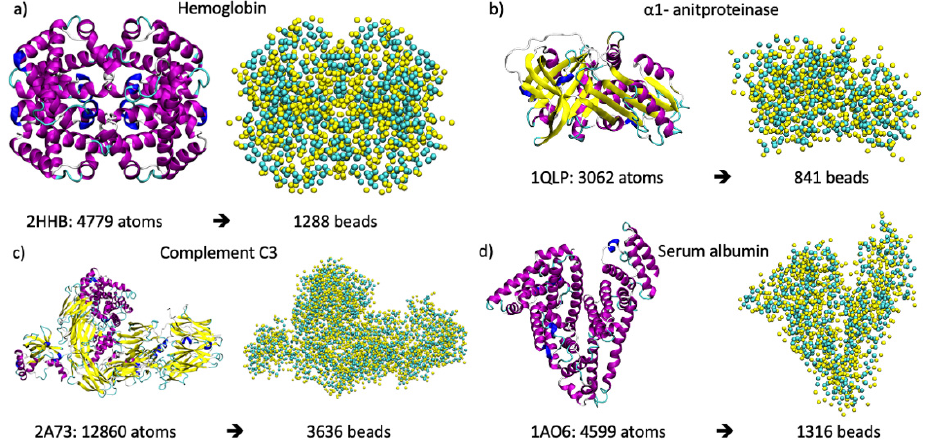
Figure 8. In each panel on the left, the representations of the three-dimensional structures of the proteins where secondary structure elements are represented in cartoons are shown, and on the right, the CG Martini model is shown, where cyan spheres are related to the backbone beads and the yellow is related to the side chains. In panel ( a ) hemoglobin; ( b ) α 1-antiproteinase; ( c ) serum albumin; and ( d ) complement C3. Below each protein, the PDB ID, the number of atoms at the atomistic level, and the number of beads at the cg level are shown.